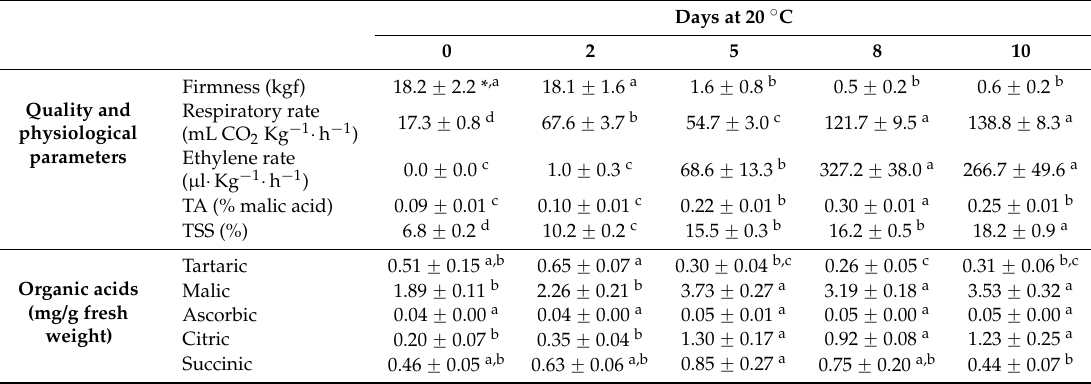
Table 3. Quality, physiological parameters and organic acid contents of cherimoya fruit during ripening at 20 ˝ C. Results are expressed as the mean ˘ SE of a series of separate determinations and extractions. TSS: total soluble solids, and TA: titratable